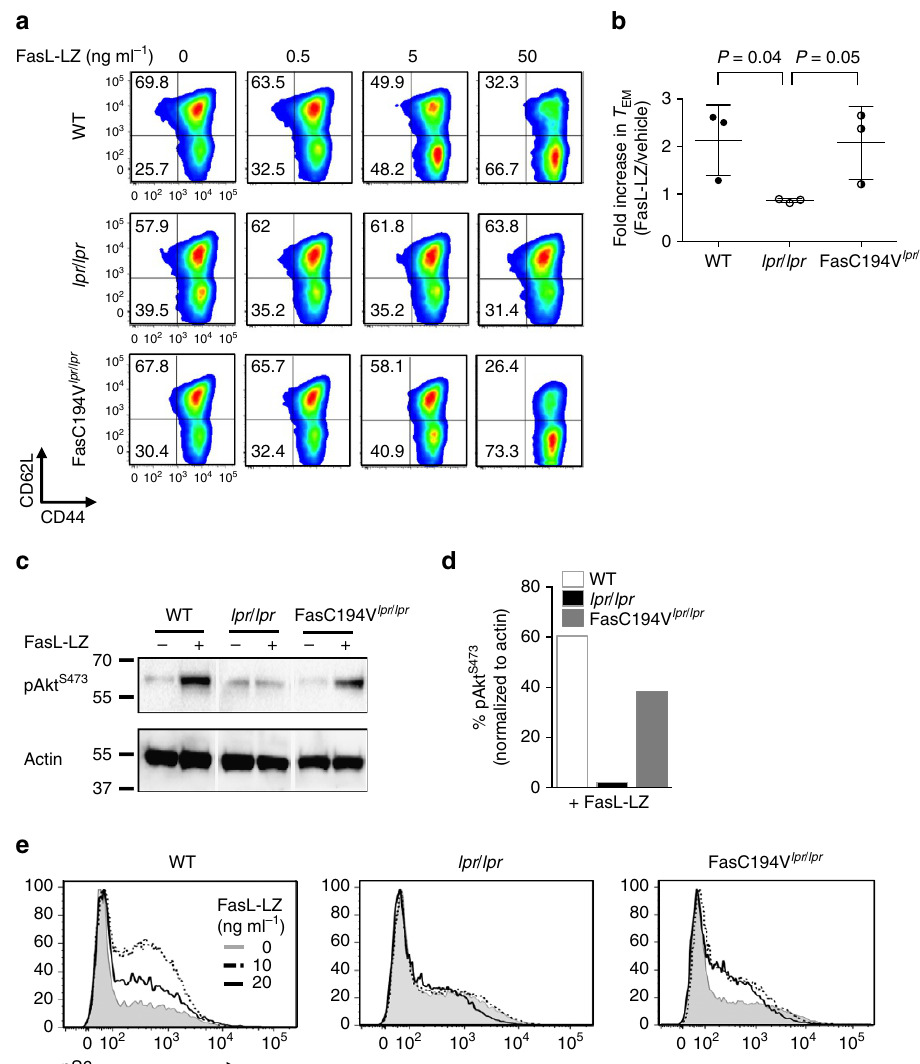
Figure 3 | The Fas C194V mutant mediates precocious T-cell differentiation. ( a ) Naive CD4 þ T cells from 10-week-old WT, lpr/lpr or FasC194V lpr/lpr mice were stimulated for 48 h with anti-CD3/CD28 in the presence or absence of the indicated doses of FasL-LZ. Activated cells were subsequently expanded for 96h in media with IL-2 in the presence or absence of FasL and subjected to flow cytometry after staining for CD44 and CD62L to delineate central and effector memory cell subsets. Fold increase of effector memory (T EM ) in cells treated with FasL-LZ versus control is summarized in b , with P ¼ 0.04 for WTversus lpr/lpr and P ¼ 0.05 for FasC194V lpr/lpr versus lpr/lpr . There was no significant difference between WTand FasC194V lpr/lpr samples. Unpaired t -test was used to calculate statistical significance. Data are representative of three independent experiments ( N ¼ 3) representing mean ± s.e.m. ( c ) Equal numbers of 6day-activated naive cells, stimulated in the presence or absence of 10ngml (cid:2) 1 FasL-LZ, from the indicated genotypes of mice were lysed and immunoblotted for pAkt S473 and actin (loading control). ( d ) pAkt S473 was quantitated from the blots in c by densitometry of pAkt S473 levels normalized to actin. The results are representative of two independent experiments ( N ¼ 2). ( e ) Intracellular staining for pS6 was performed on CD4 þ T cells activated as in a for 6 days with FasL at the indicated doses. Data are representative of two independent experiments ( N ¼